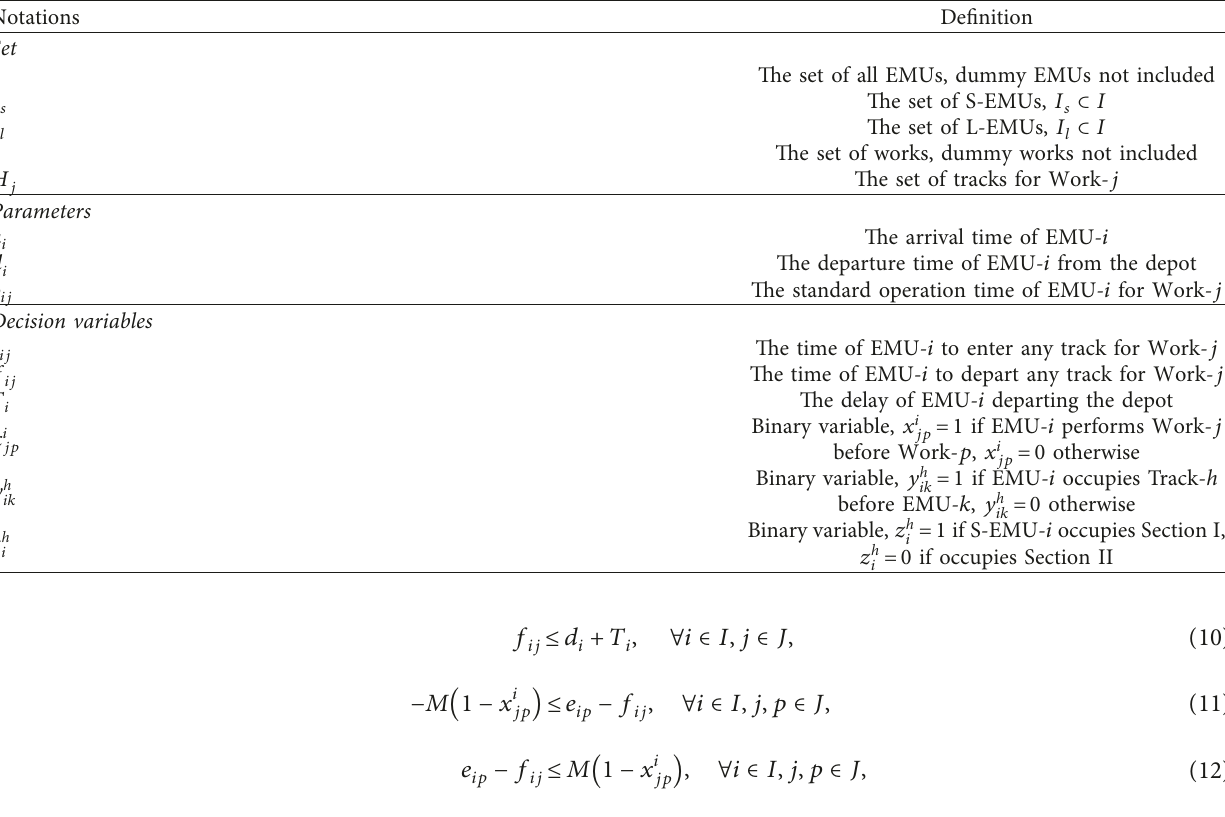
Figure 3: The occupancy flow of each track in one yard. Table 1: Notations used in the